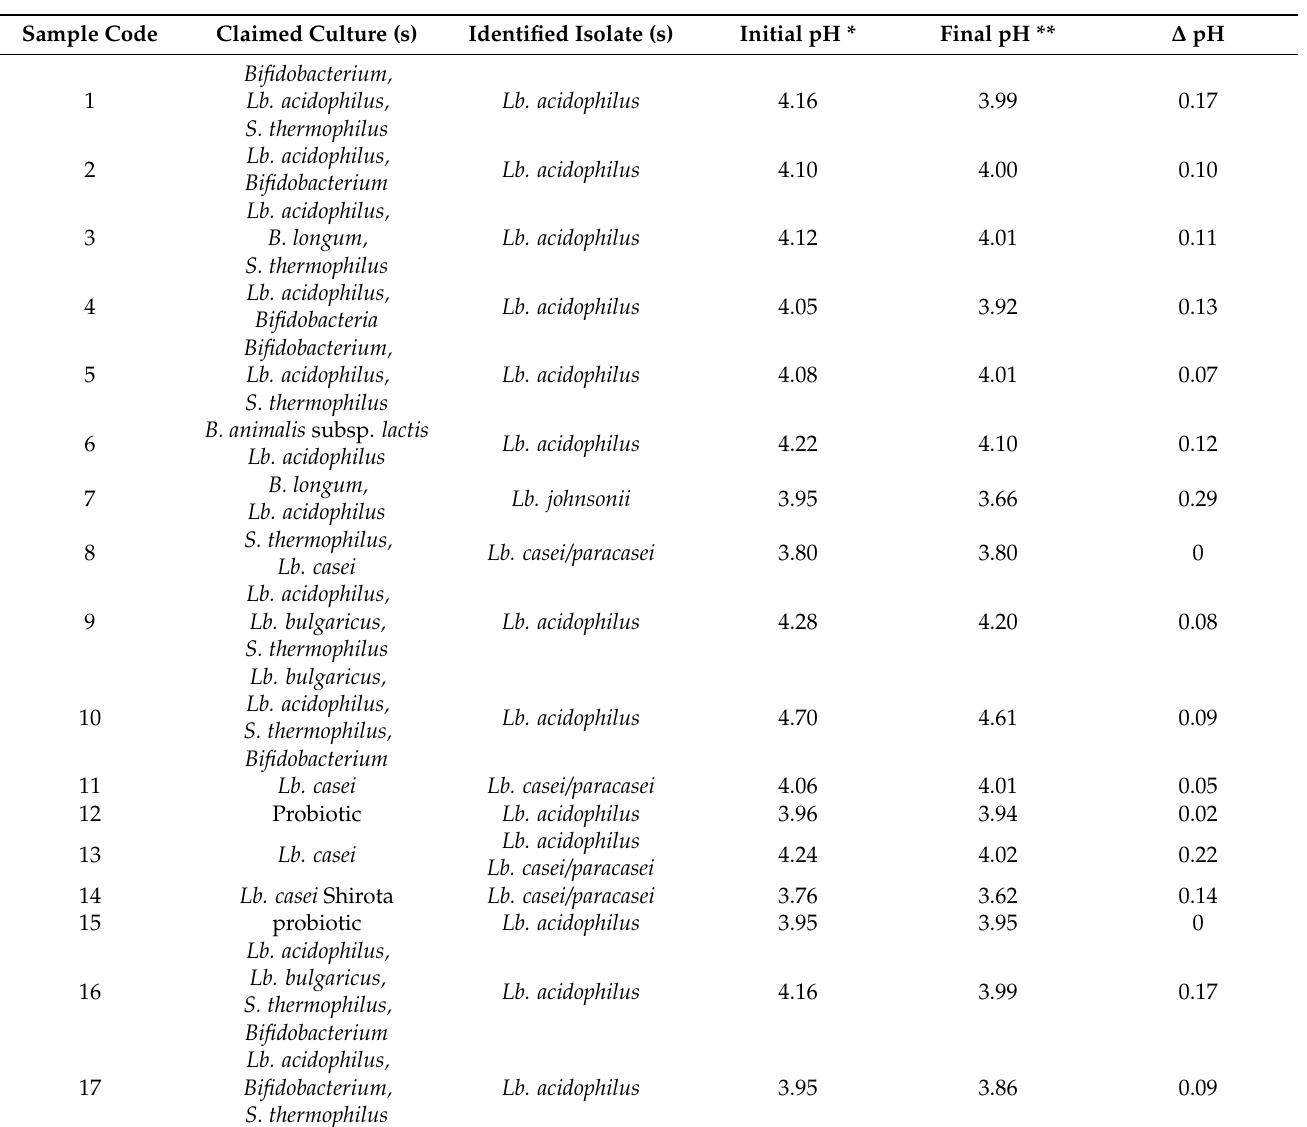
Table 2. The identity of probiotic lactobacilli isolated from commercial fermented milks by sequence analysis of 16s rRNA and rpoA genes, compared with claimed cultures by manufacturers, as well as the initial, final, and changes in the pH of the tested